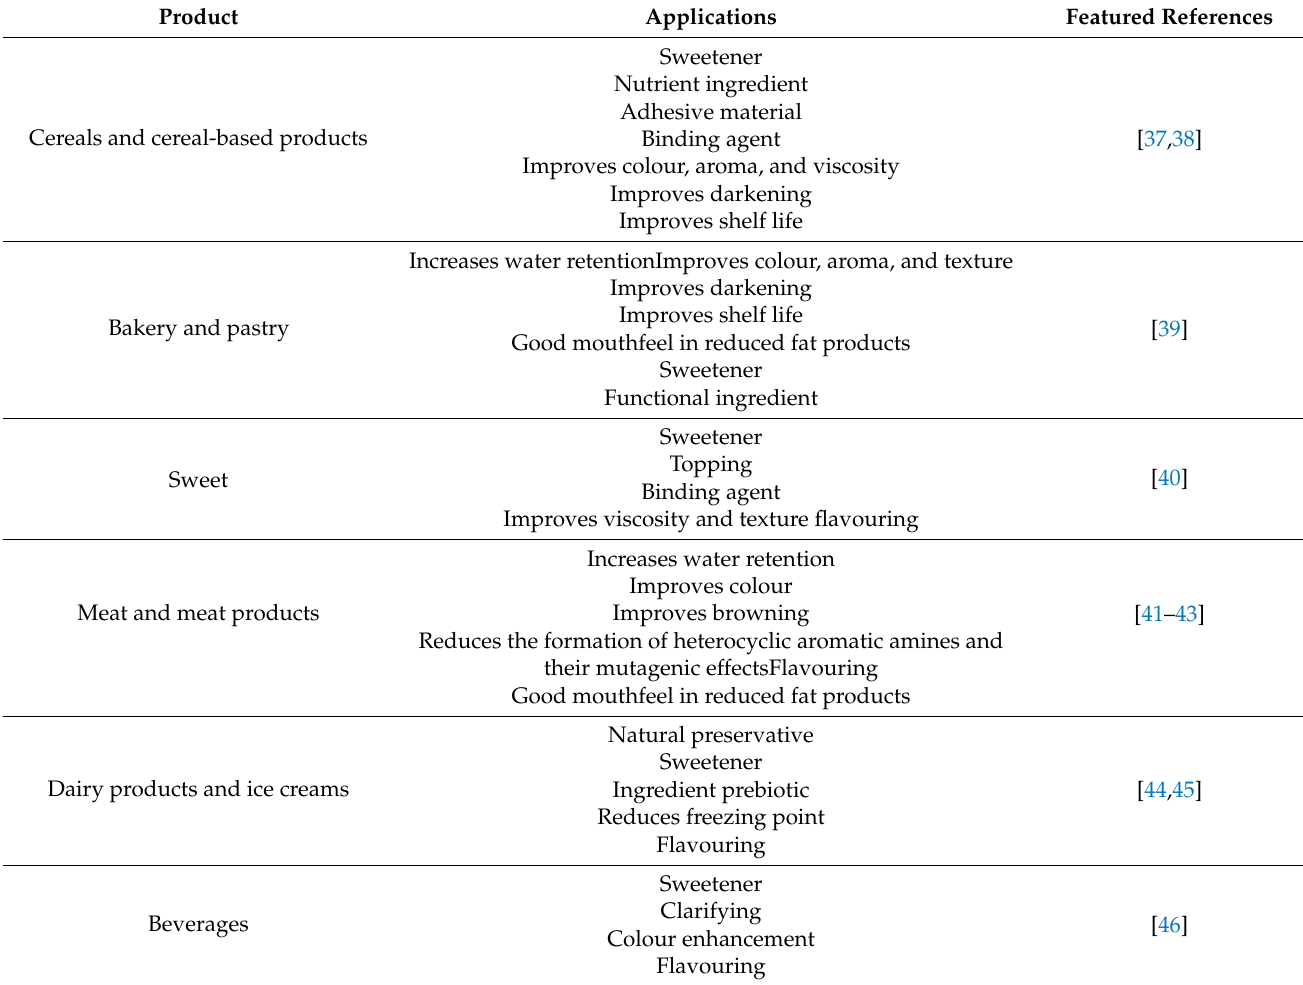
Table 3. Main applications of honey in the food